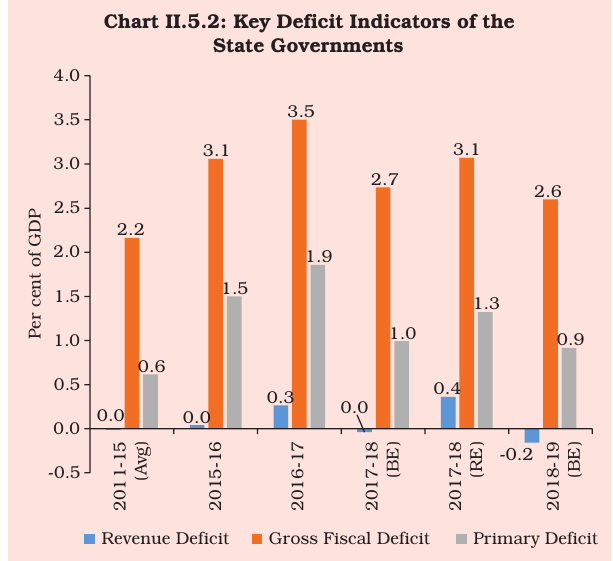
Chart II.5.2: Key Deficit Indicators of the State